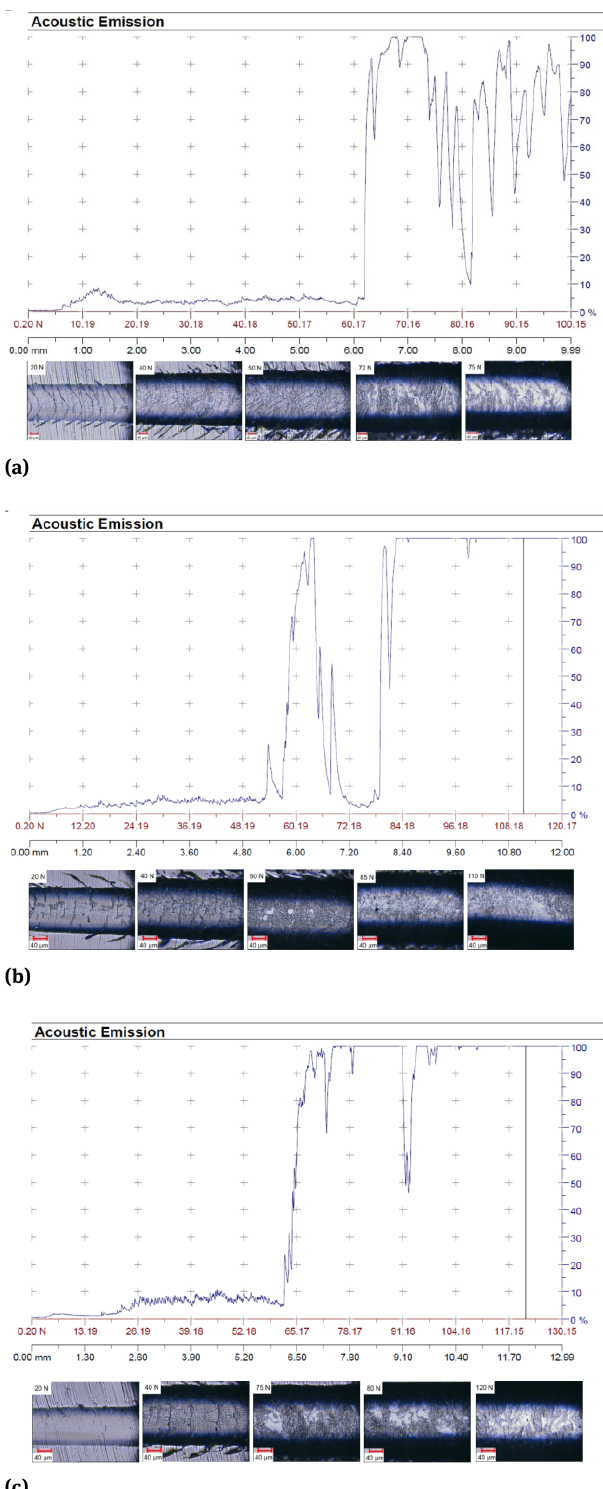
Figure 5: Progressively loading-acoustic emission of a- C1 b-C2 c-C3